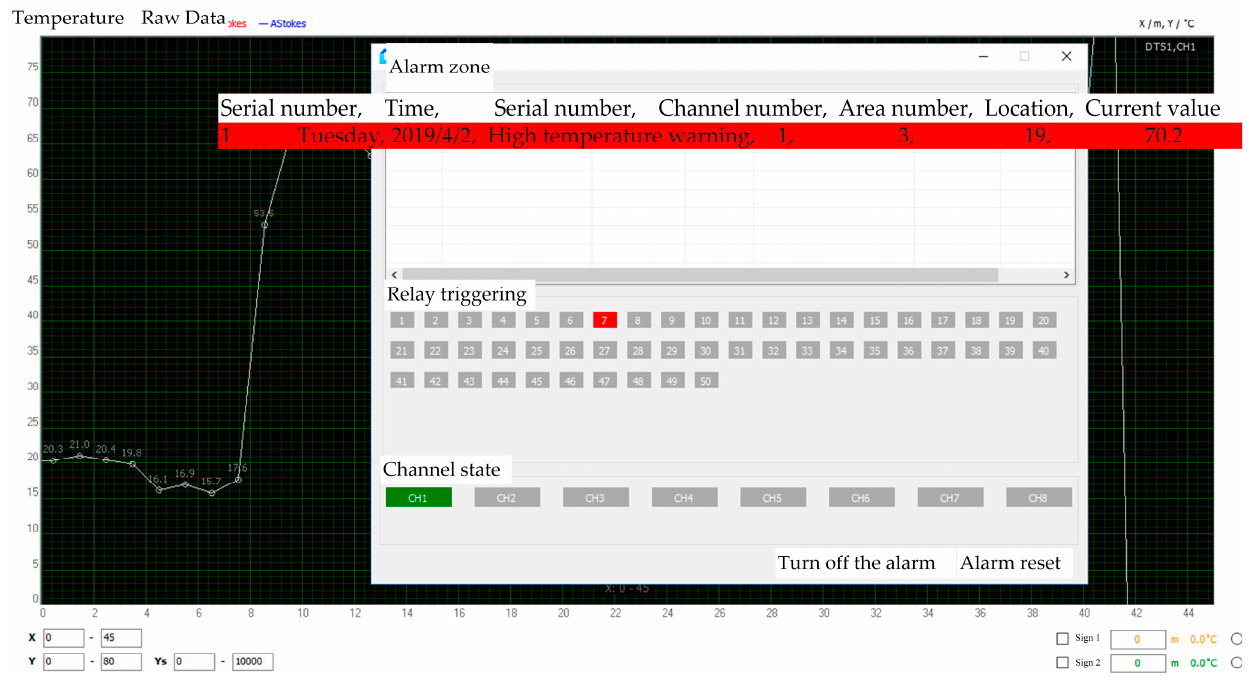
Figure 9. Interface image of DTS high-temperature alarm system.